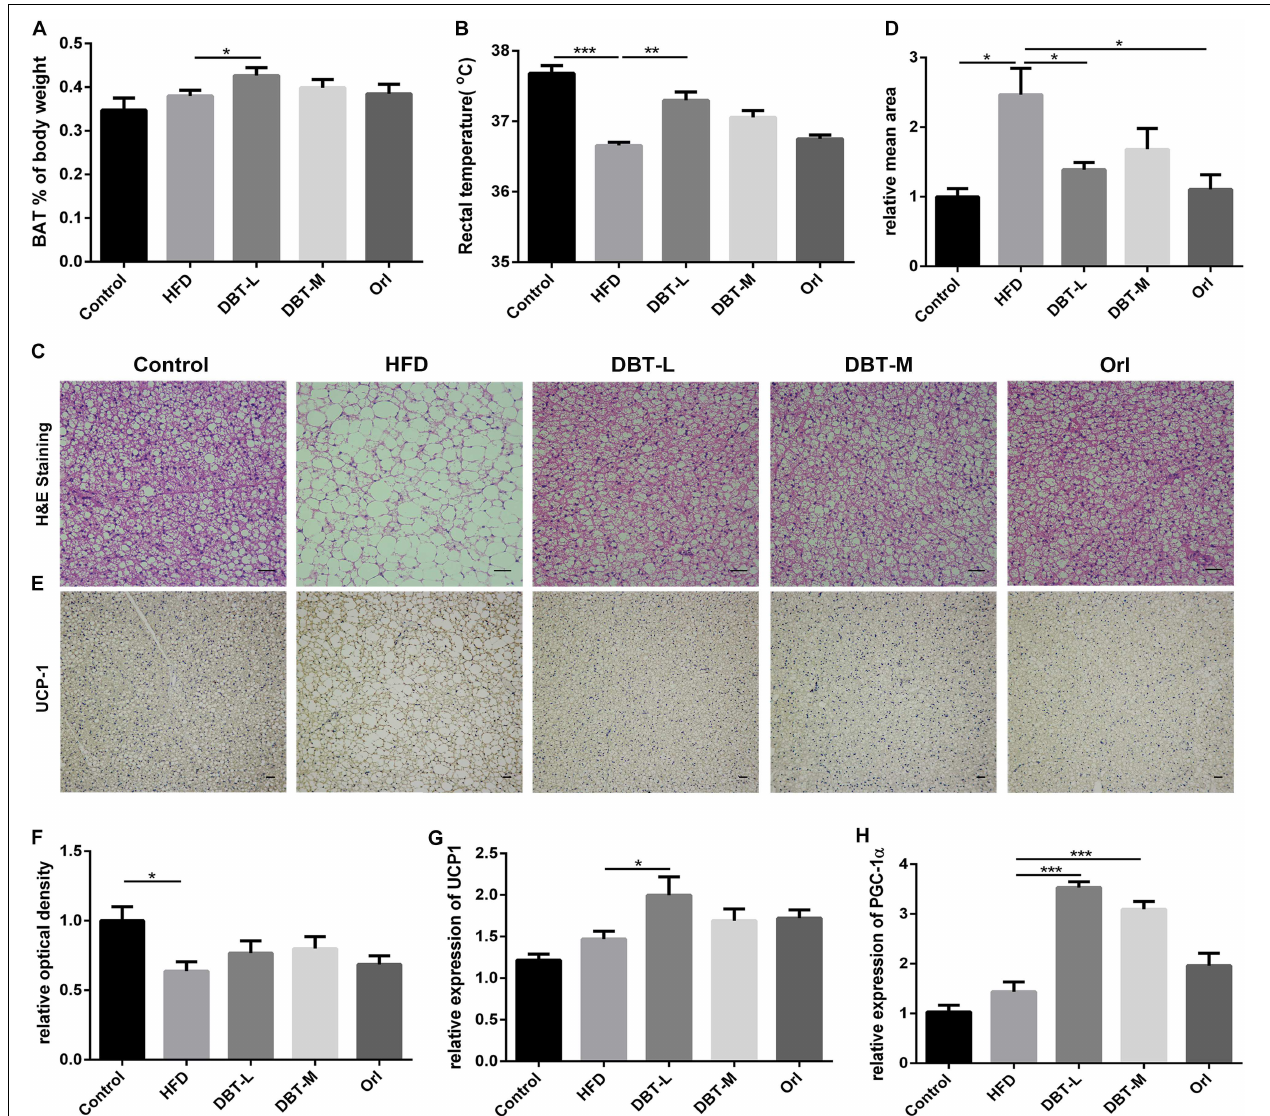
FIGURE 3 | DBT promotes BAT thermogenesis. (A) Ratio of BAT to body weight; (B) Rectal temperature measured at 0900 h; Haematoxylin and eosin staining of BAT (C) and relative mean area (D) , scale bar: 20 µ m; UCP1 immunohistochemistry of BAT (E) and relative optical density (F) ; qPCR analysis of the mRNA levels of UCP1 (G) and PGC-1 α (H) . Results are presented as mean ± SEM ( n = 7). ∗ p < 0.05, ∗∗ p < 0.01, ∗∗∗ p < 0.001 compare with HFD